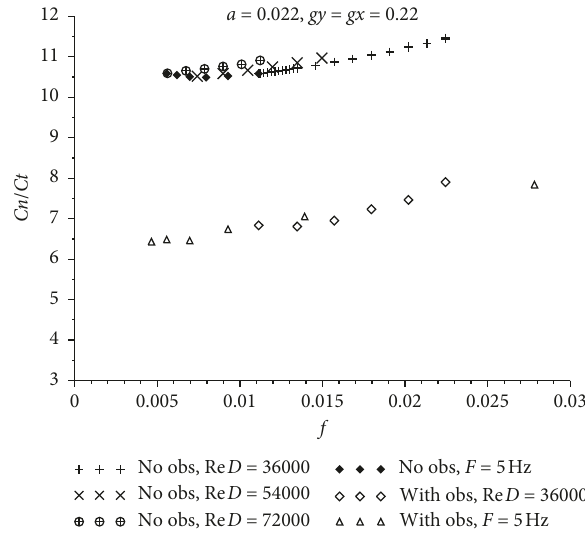
Figure 18: Evolution of Cn / Ct as a function of the dimensionless frequency f